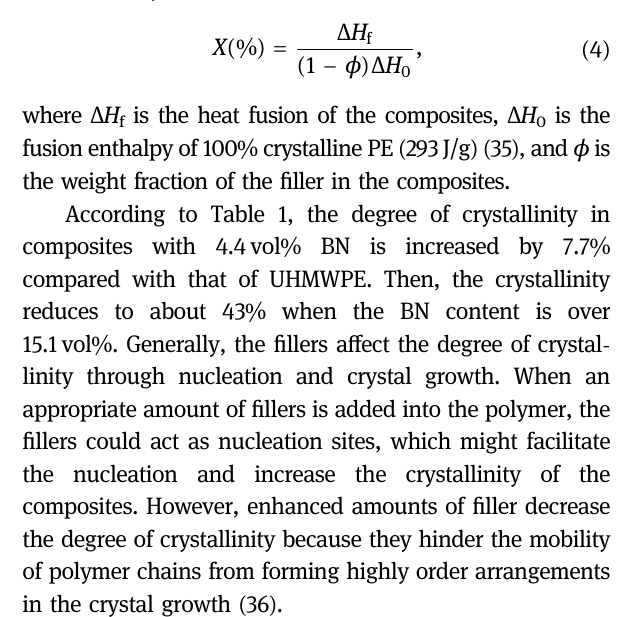
Figure 7: TGA curves of native UHMWPE and BN@UHMWPE